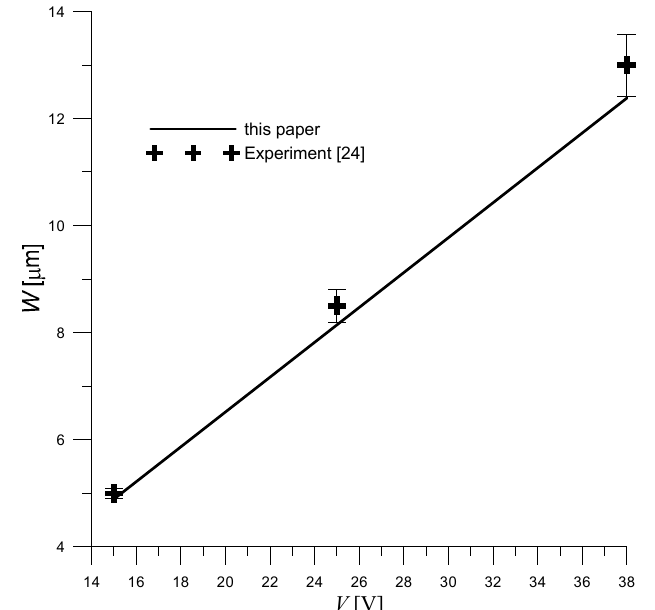
Figure 5. Comparison of the analytical solution (23) obtained for the unimorph actuator with experimental data [24] (Adapted from Mo, C.; Wright, R.; Slaughter, W.S.; Clark, W.W Behaviour of a unimorph circular piezoelectric actuator. Smart Mater. Struct. 2006, 15, p. 1102).